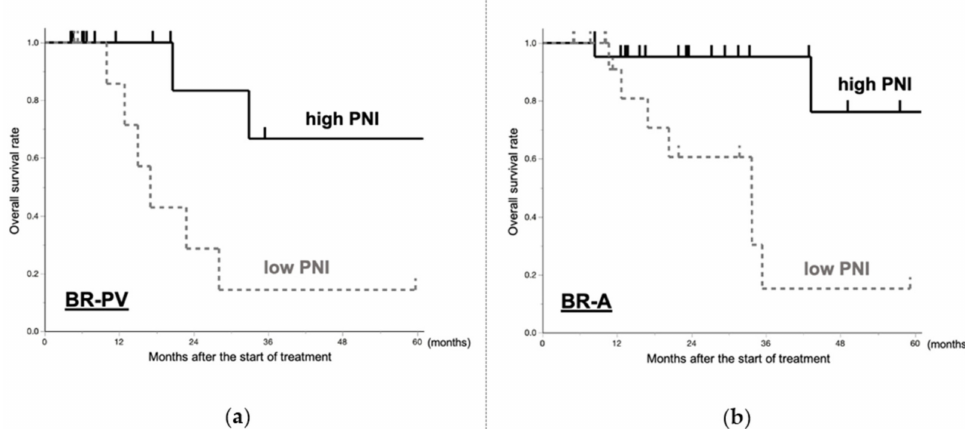
Figure 4. Comparison of the overall survival between high preoperative PNI and low preoperative PNI in the ( a ) BR-PV and ( b ) BR-A groups. The prognosis of patients with high preoperative PNI was significantly better than that of patients with low preoperative PNI in the BR-PV and BR-A patients ( p = 0.029 and p = 0.012). PNI, prognostic nutritional